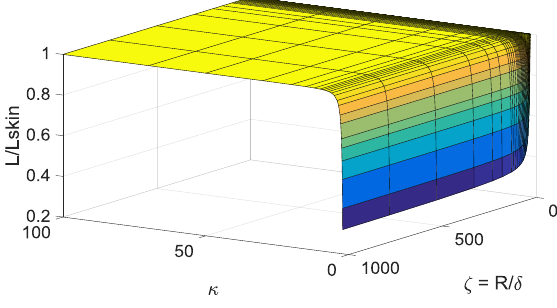
Figure 10: Pseudo 3D plot of the analytically approximated ratio 𝐿/𝐿 𝑠𝑘𝑖𝑛 for very large 𝜅 and 𝜁